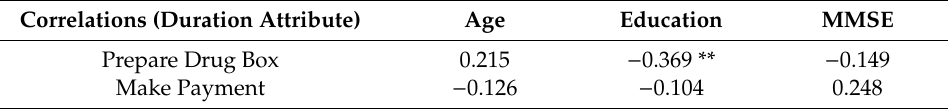
Table 5. Correlations between the activities, age, education and MMSE in Thessaloniki.